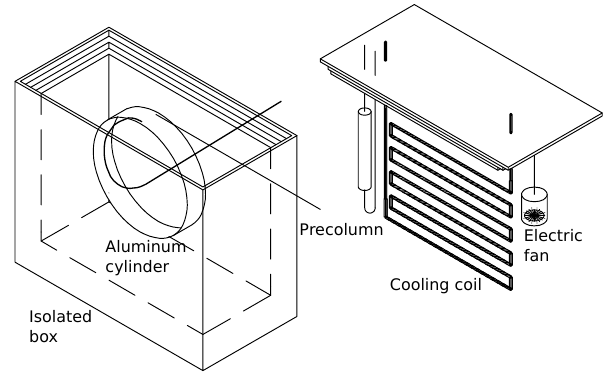
Figure 1. Expanded view of the box used for the coating proce- dure. Inside the box the air is recirculated by a fan (Micronel) to avoid temperature gradients. The temperature is monitored with two Pt100 sensors mounted at the top and bottom of the